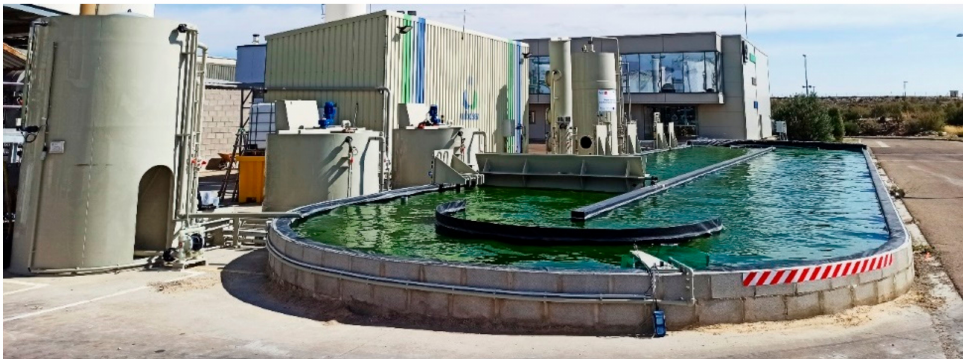
Figure 15. Photosynthetic biogas upgrading plant under validation in URBIOFIN